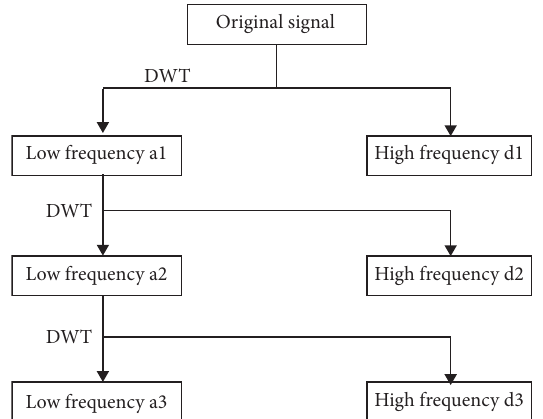
Figure 2: Schematic diagram of the DWT decomposition